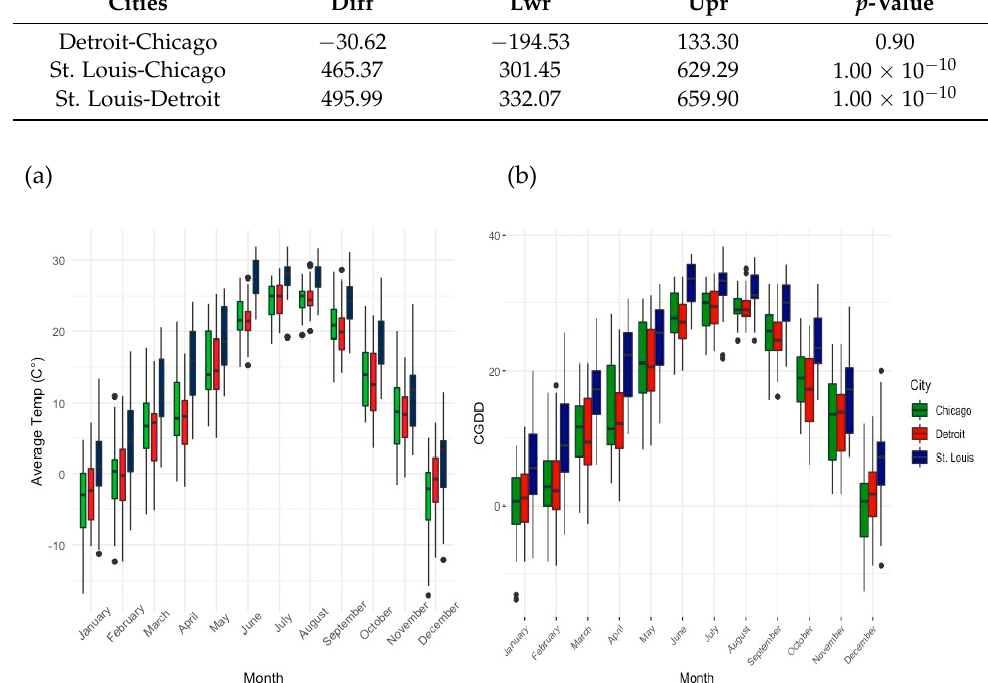
Figure 4. Climatic differences between the three sampled cities, Chicago, Detroit, and Saint Louis, including ( a ) average temperature from NOAA climate data throughout 2016 and ( b ) cumulative growing degree days throughout 2016.